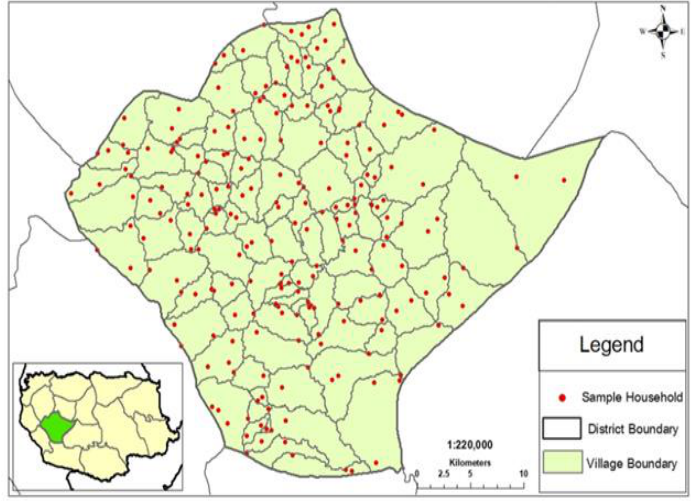
Figure 1. Map of Champhone District in Savannakhet Province.